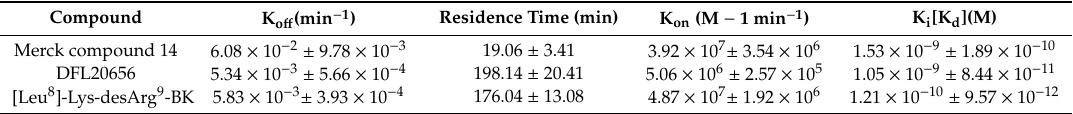
Table 1. Summary of kinetic binding data for the compounds analyzed. For Merck compound